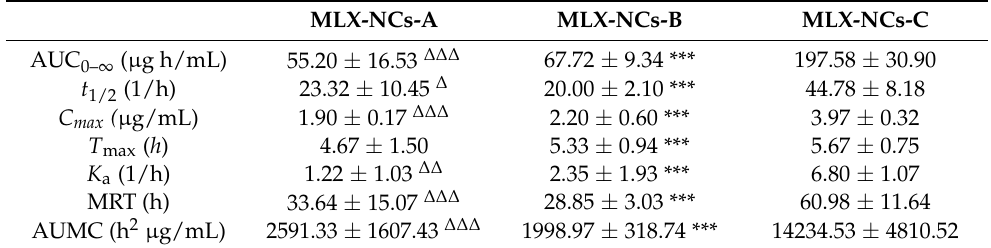
Figure 11. Plasma concentration–time curves of MLX-NCs-A, MLX-NCs-B, and MLX-NCs-C in rats after oral administration (mean ± SD., MLX-NCs-A and MLX-NCs-B n = 7; MLX-NCs-C n = 6). Table 2. Pharmacokinetic parameters after the oral administration of MLX-NCs-A, MLX-NCs-B, and MLX-NCs-C in rats. (0.5 mg/kg, mean ± SD, MLX-NCs-A and MLX-NCs-B n = 7; MLX-NCs-C n = 6).